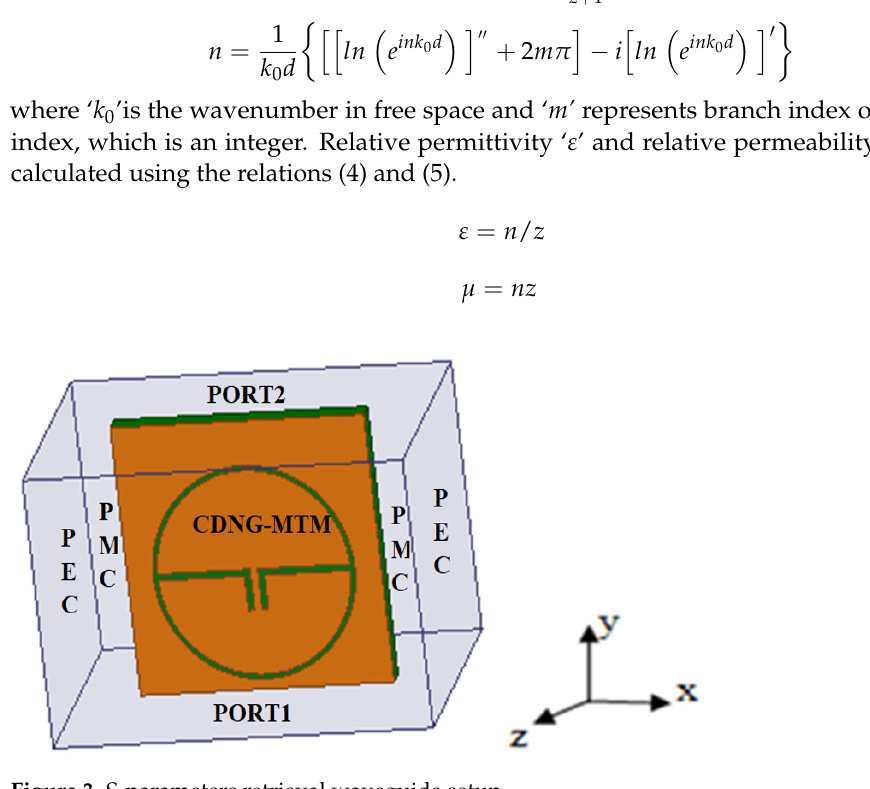
Figure 3. S-parameters retrieval waveguide setup .